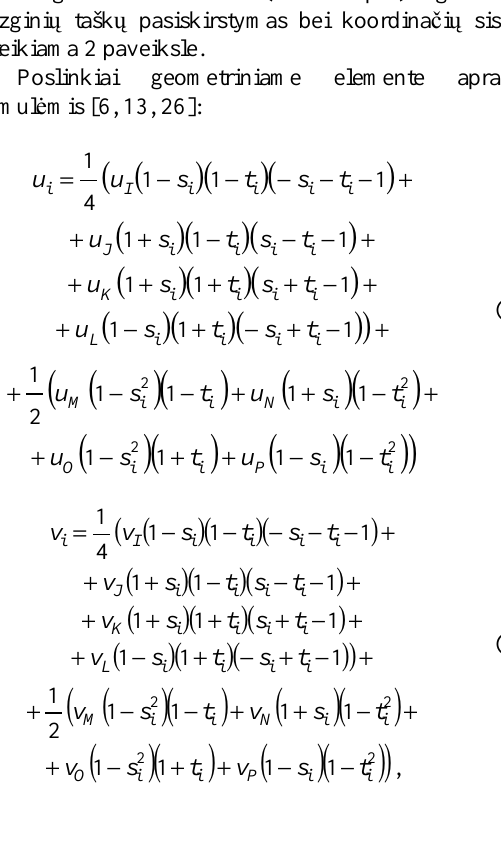
Fig 2. Geometrical scheme of the finite element baigtiniame elemente kinta nuo –1 iki +1.